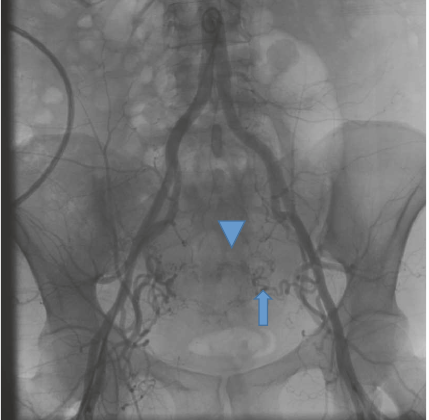
Figure 2: Pelvic aortogram showing a hypervascular area in the region of the cervical ectopic pregnancy (arrowhead) being supplied mainly by the left uterine artery